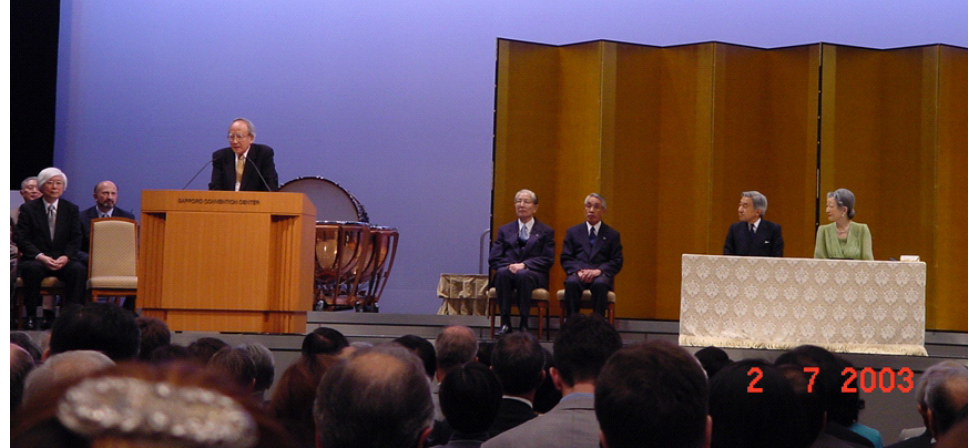
Figure 1. Opening ceremony of the XXIII IUGG General Assembly. Seiya Uyeda, Chair of the Local Organizing Committee (welcoming the Assembly’s participants) on the left, and His Majesty The Emperor of Japan and The Empress of Japan on the right of the photo (courtesy: S.